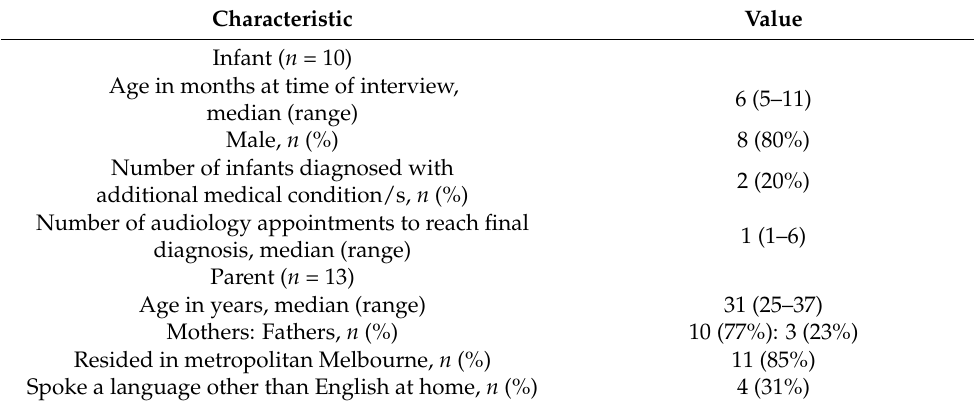
Table 1. Participant